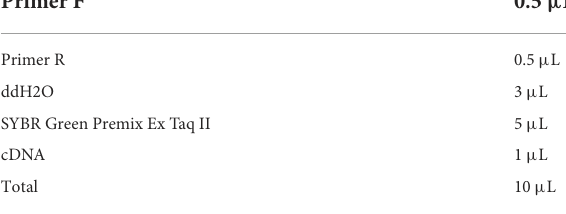
TABLE 2 RT-qPCR reaction system of PEDV ORF1